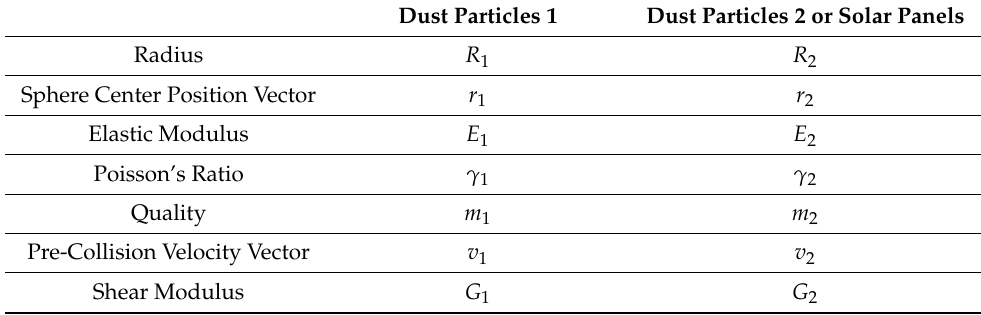
Table 1. Parameters for two spherical